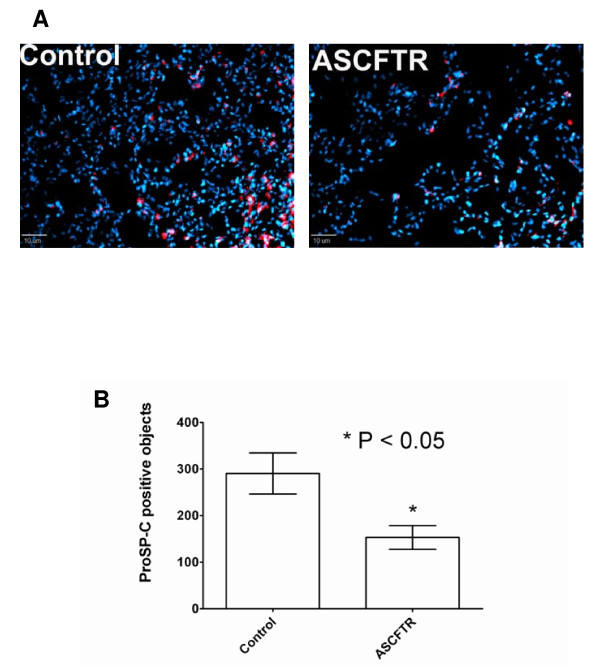
Immuno-staining of lung sections for proSP-C. A. Sections of frozen lungs from Control and ASCFTR rats were probed with polyclonal antibodies to proSP-C and then with Cy3-labeled secondary antibodies (red). The cell nuclei were counter-stained with DAPI (blue). The sections were viewed with a fluorescence microscope and photographed after deconvolusion and normalization of Cy3 fluorescence intensity to the same range of pixel density for the Control and ASCFTR specimens. B. A comparison of fluorescent object count between the Control and ASCFTR specimens showed a significant decrease in proSP-C positive cells (ATII cells) in the ASCFTR group in comparison to the Control group.